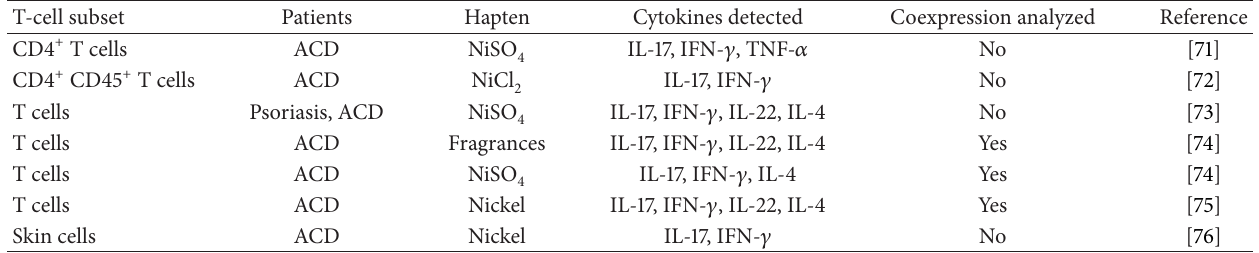
Table 1: Summary of studies on human Th17 cells. T-cell lines were derived from skin biopsies by limiting dilution and further specified for CD4 or not. Skin cells were analyzed without specification of the phenotype. In some studies, coexpression of IL-17 with cytokines specific for Th1, Th2, or Th22 was analyzed by flow